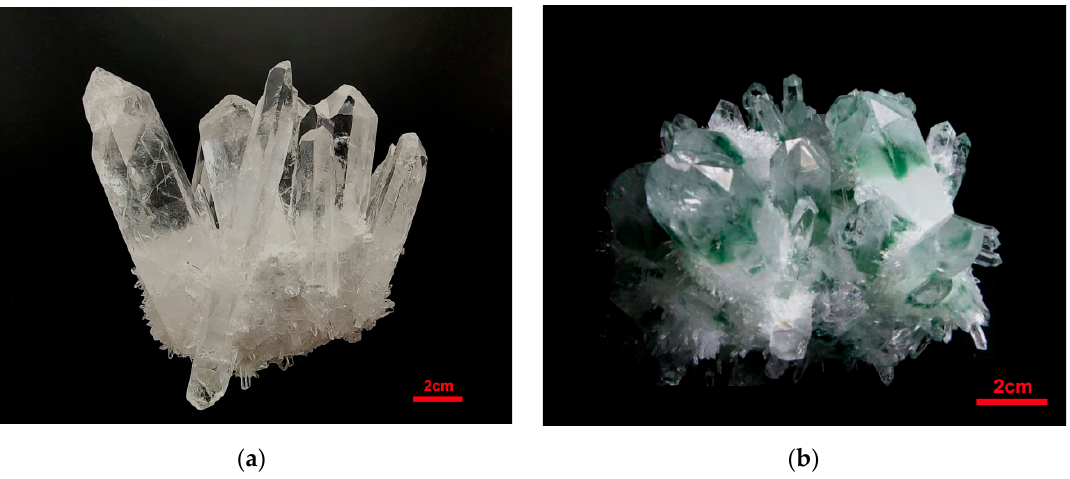
Figure 1. Investigated regrown quartz crystal druse samples Q-1 ( a ) and Q-2 ( b )